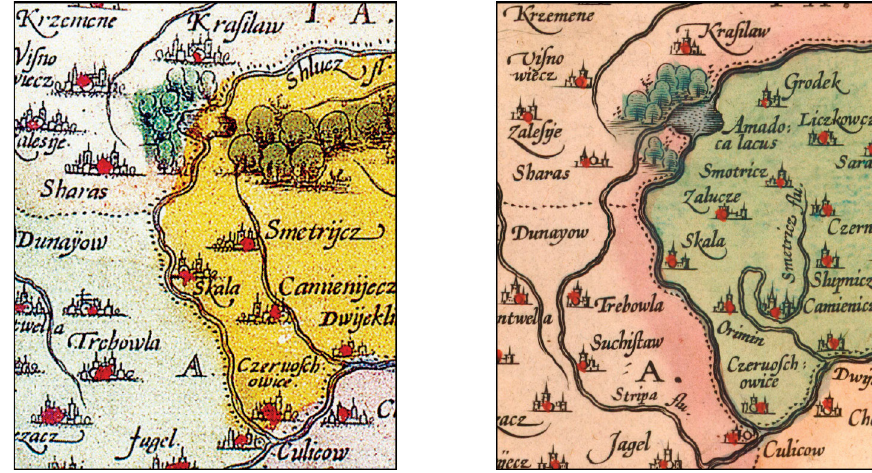
Fig. 3. State and administrative borders on maps of Poland: a – by W. Grodecki and b – A.